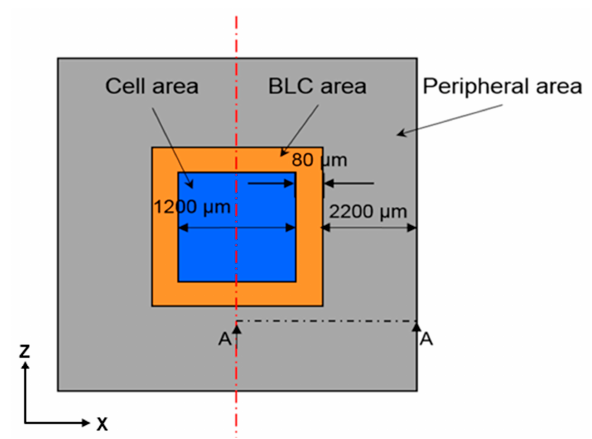
Figure 1. Top view (x-z plane) of the stacked-film architecture. It is a symmetrical structure divided into a cell area, a BLC area, and a peripheral area.